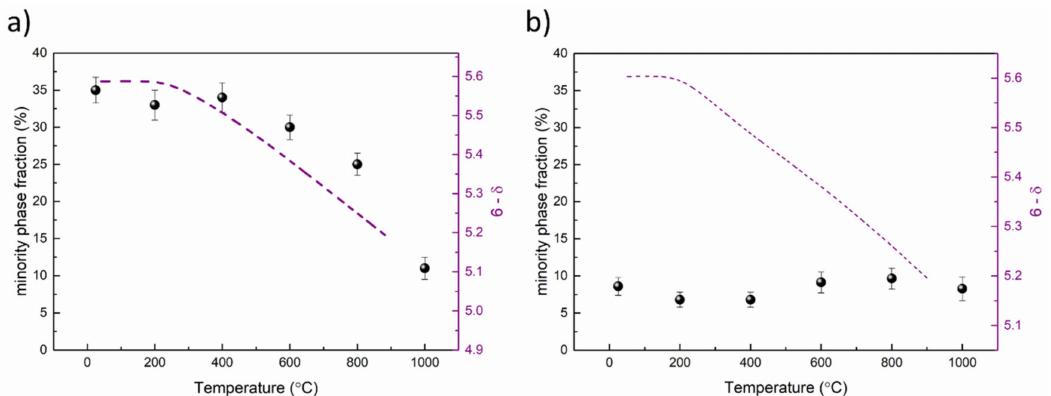
Figure 5. The fraction of the minority phases (dot) P4 / mmm for BLC ( a ) and Pm3 m for BNC ( b ), and oxygen stoichiometry (dashed line) as a function of temperature. The oxygen stoichiometry changes were calculated based on thermogravimetry using titration results as a starting point.